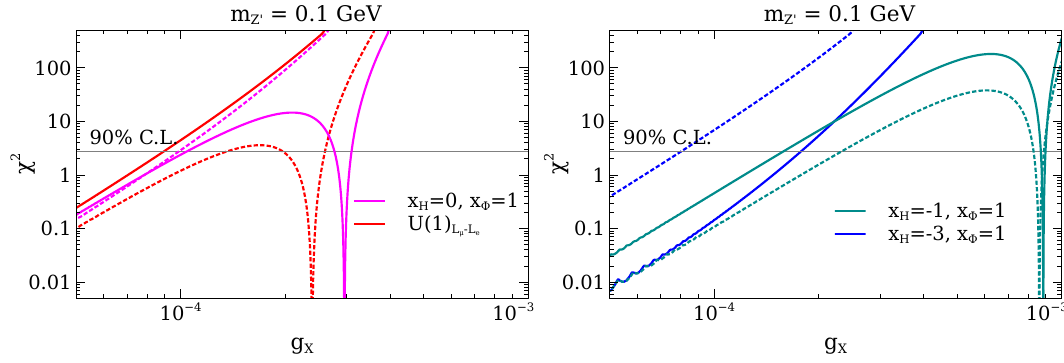
Figure 3 . χ 2 as a function of the coupling constant for neutrino (solid) and anti-neutrino (dashed) modes using the total rate at DUNE ND.